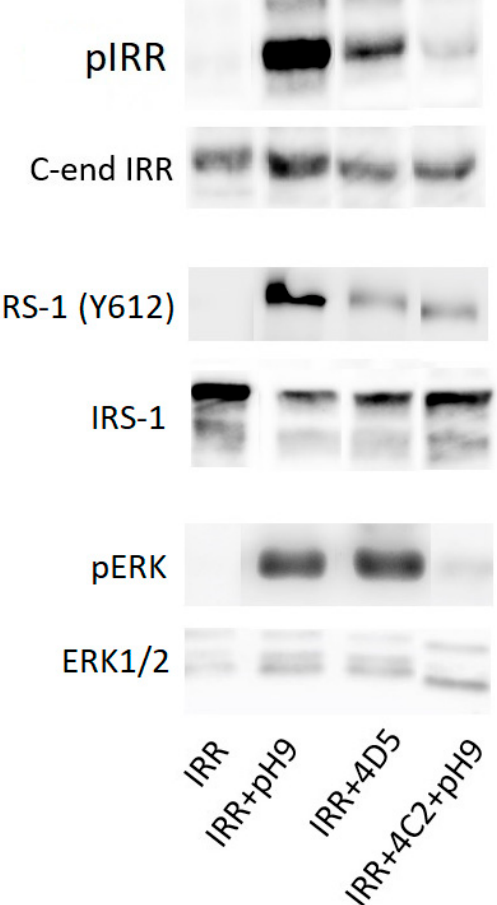
Figure 3. Activation and inhibition of the IRR downstream signaling pathways in IRR-transfected HEK293 cells.